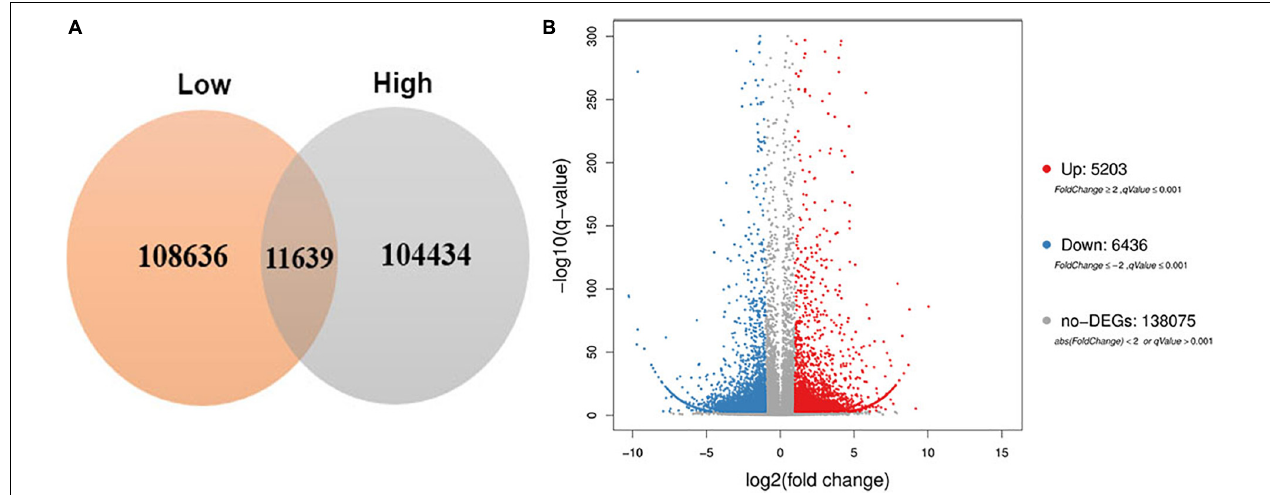
FIGURE 4 | Venn diagram and volcano plot of DEGs at low and high altitudes. (A) Venn diagram showed DEGs expressed at each of the two altitude treatments. (B) Volcano plot showed the numbers of DEGs identified in comparisons between pairs of